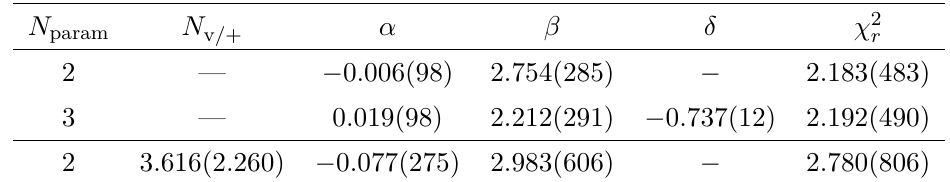
= 2 , where the smooth param